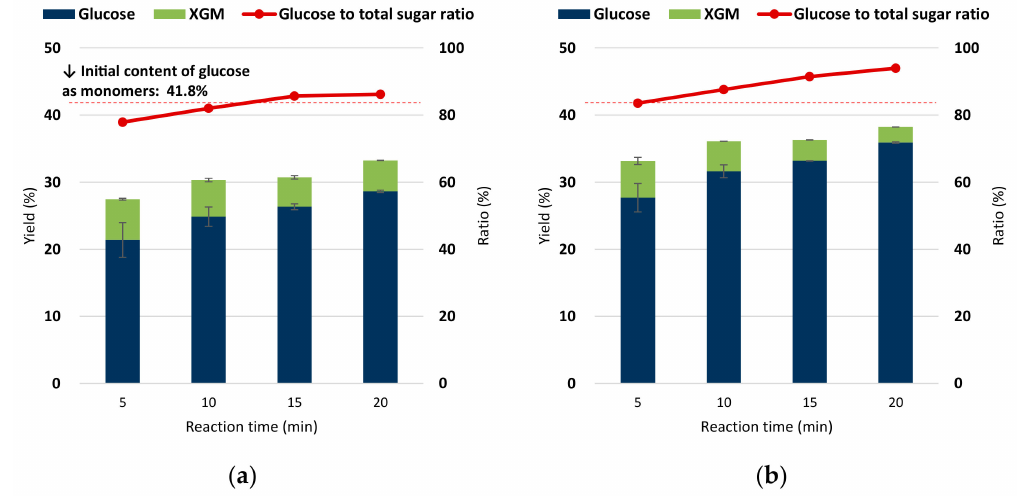
Figure 4. Glucose content and conversion ratio after enzymatic hydrolysis: ( a ) 180 ◦ C; ( b ) 190 ◦ C.